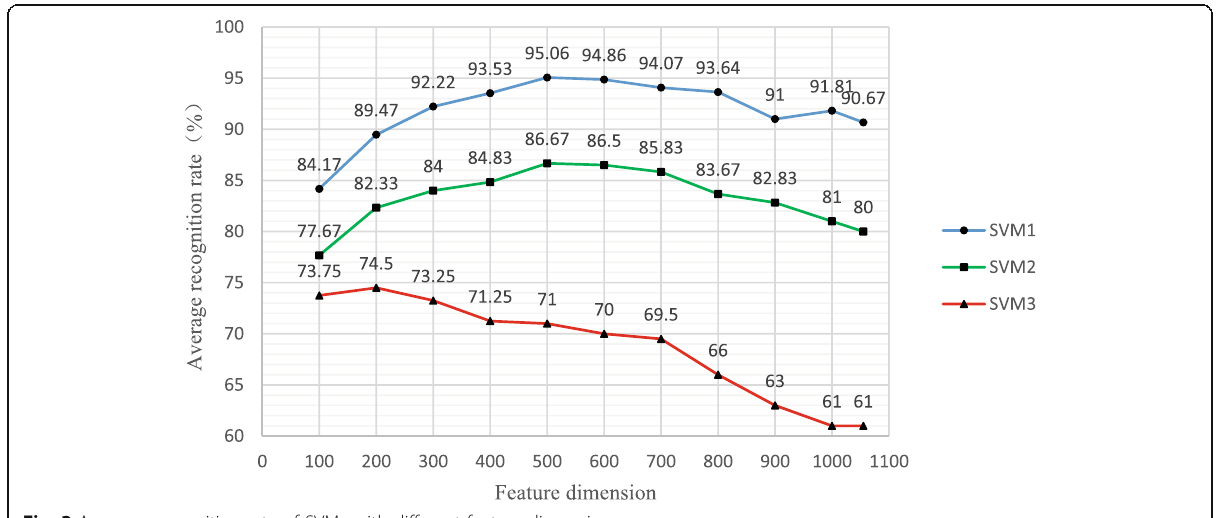
Fig. 3 Average recognition rate of SVMs with different feature